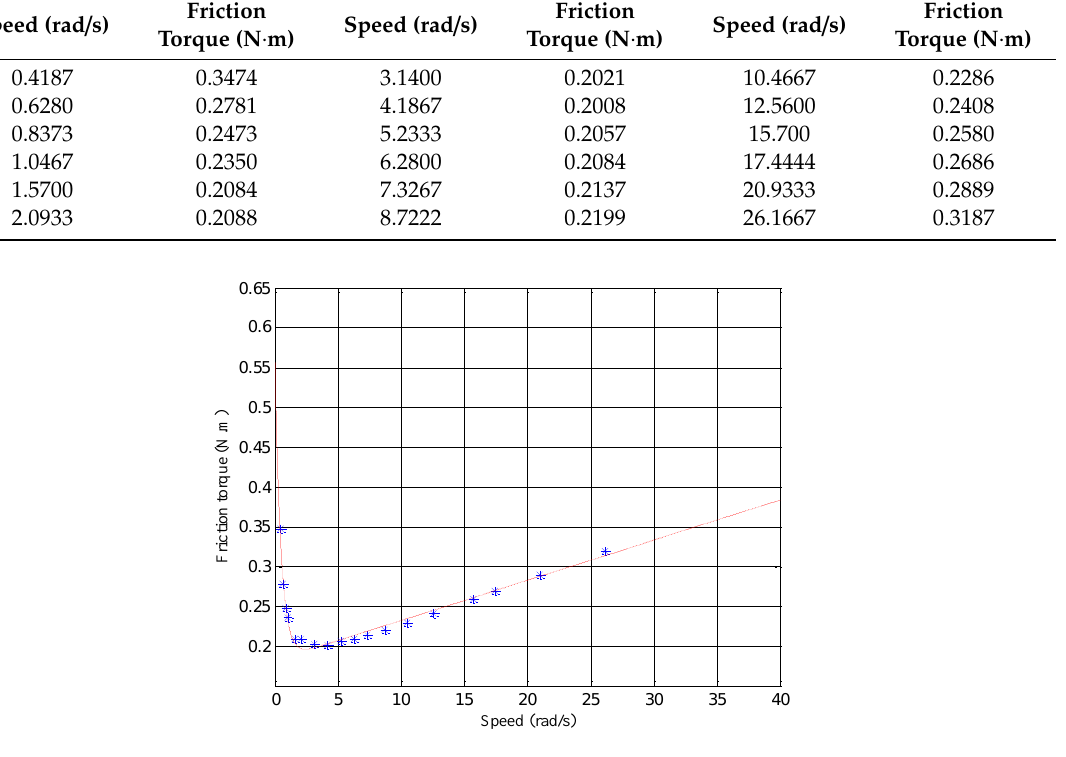
Table 1. Measurement results of the friction torque of a RV reducer.